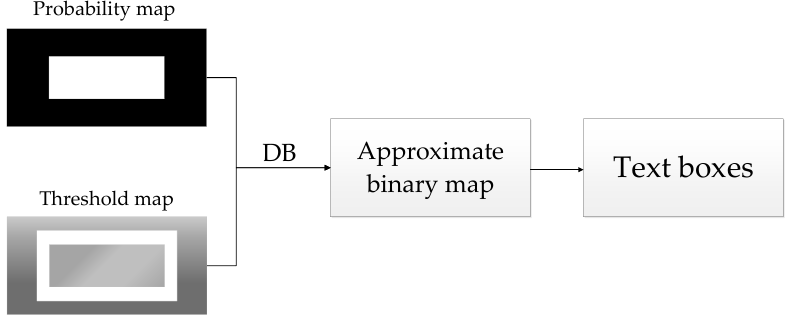
C O N C A T Figure 4. Adaptive multiscale feature fusion framework. 3.3. Text Bounding Boxes Inferencing In this paper, the improved segmentation-based method DBNet is used to infer the text position in the complex scene images, and the feature map is predicted through train-